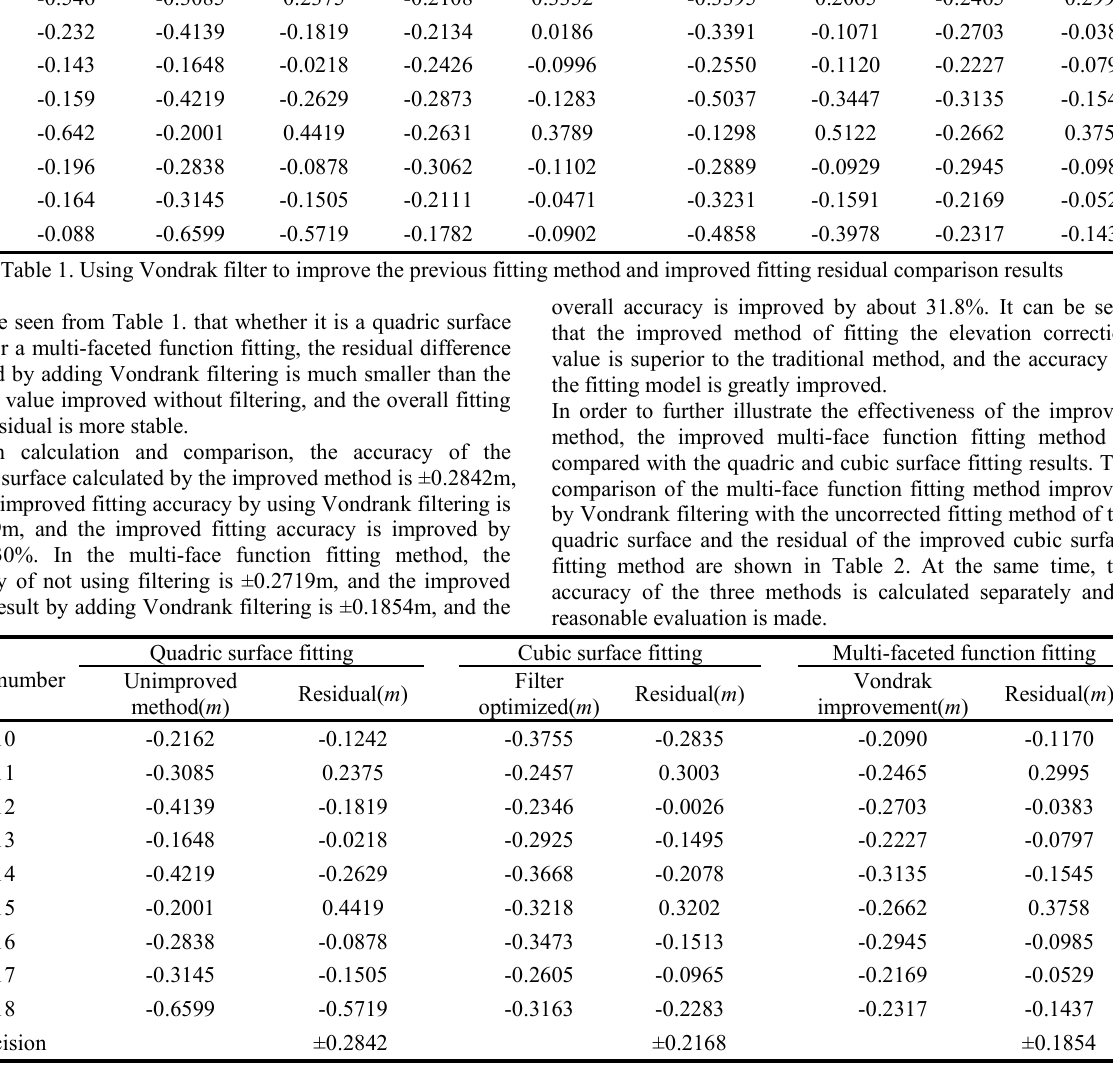
Table 2. Compare the accuracy analysis results of the three fitting